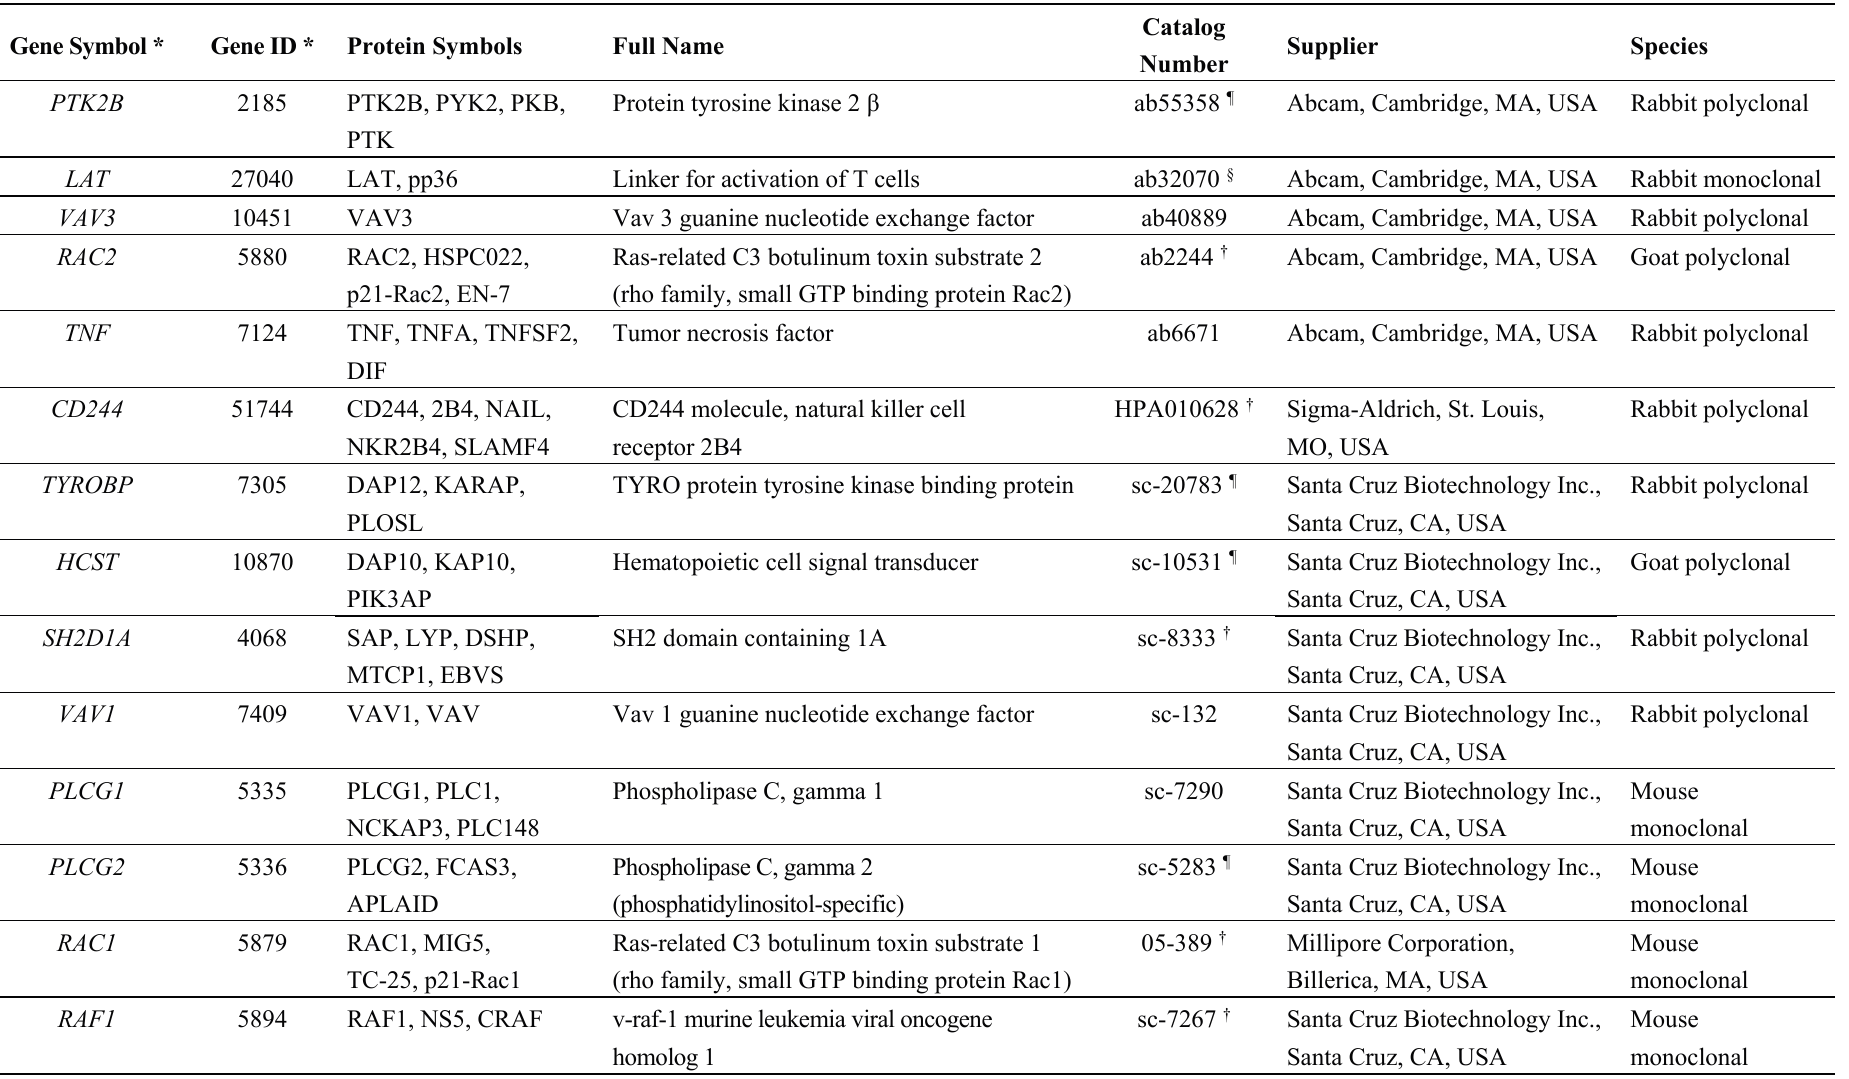
Table 2. Primary antibodies used for immunohistochemical staining of aortic tissue